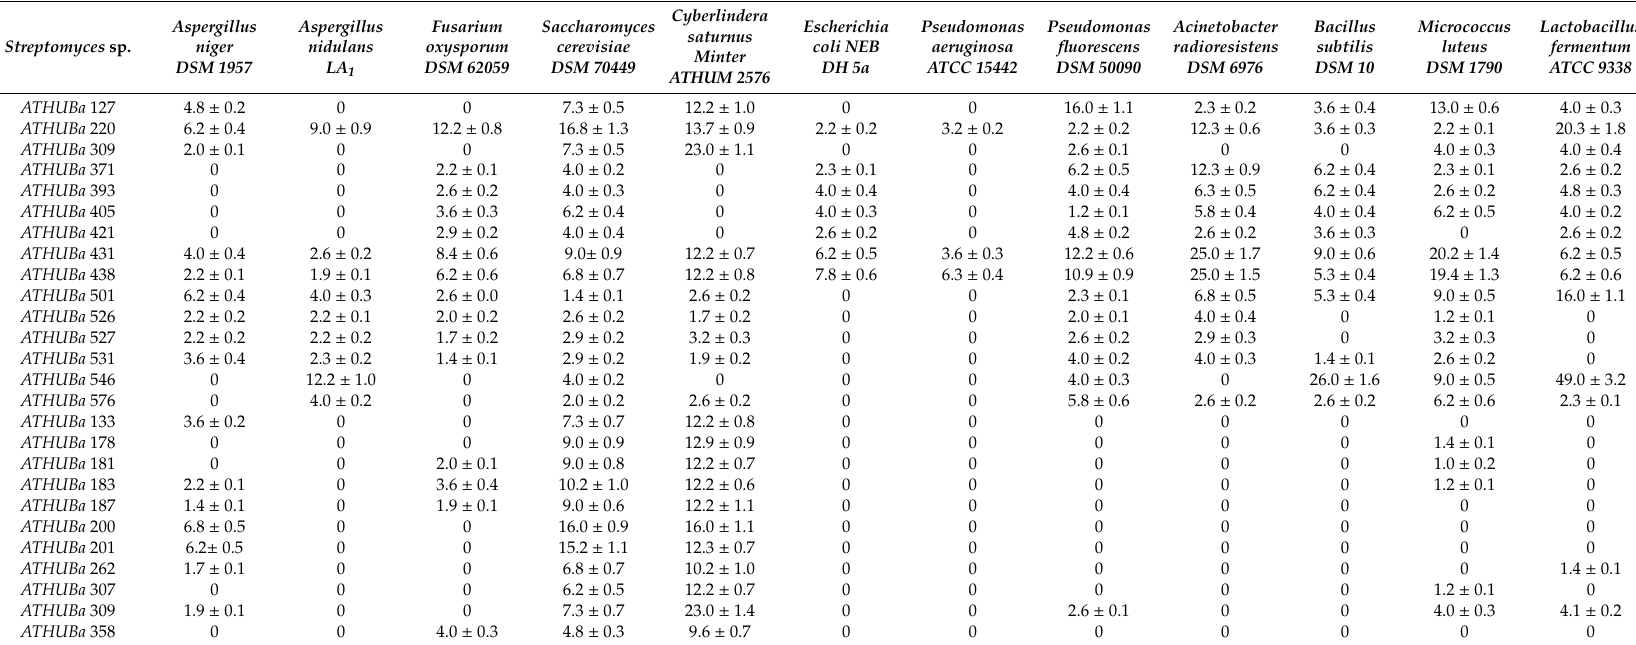
Table 1. Diameter of inhibition halo (mm ± standard error) formed around each of the 26 Streptomyces isolates, tested against the 12 target microorganisms.